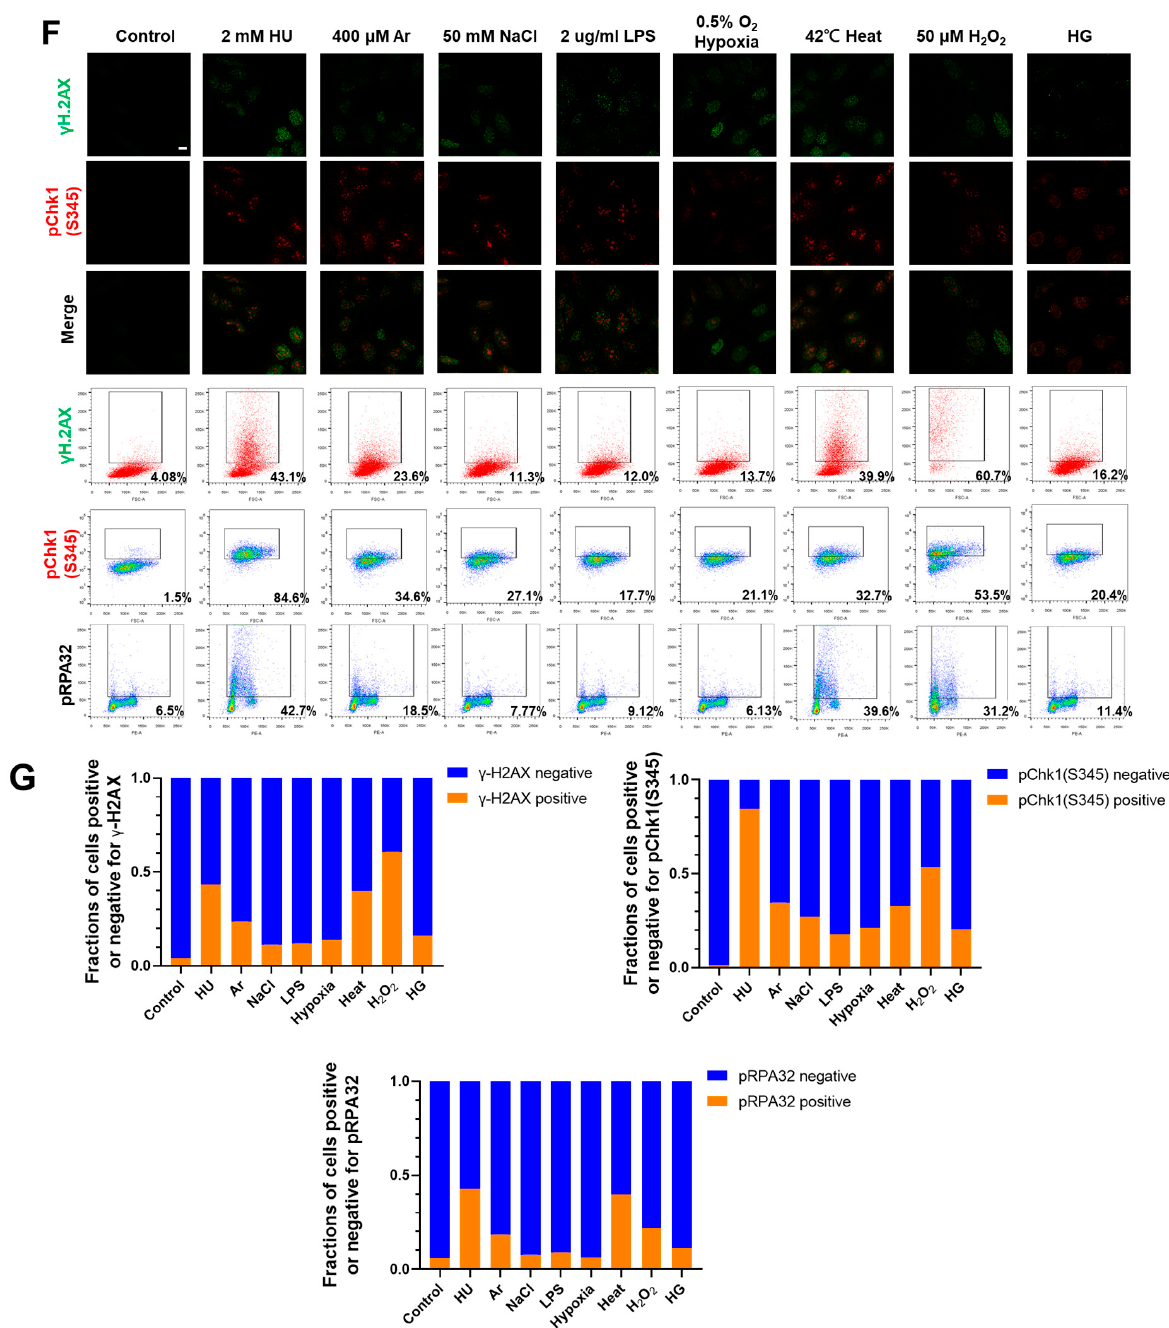
Figure 1. Various cellular stresses differentially affect DNA replication and induce DNA damage and replication checkpoint in a cell-cycle stage-dependent manner. ( A ) U2OS cells were exposed to indicated cellular stresses for 3 h, EdU-labeled for 15 min, and stained with indicated markers. Cells were then visualized and analyzed by confocal microscopy (Zeiss LSM780). Representative images are shown. Scale bar is 10 µ m. Green, DAPI (DNA); white, EdU (DNA synthesis); red, pChk1(S345) (replication checkpoint); green, γ -H2AX(DSB). A long exposed version of pChk1 (S345) is also shown. ( B ) and ( C ) U2OS Fucci cells were exposed to indicated cellular stresses for 3 h and subjected to immunostaining. Cells were then analyzed by confocal microscopy (Zeiss LSM780). Representative images are shown. Scale bar is 10 µm. Blue, Hoechst (DNA); green, geminin (S/G2 marker): red, Cdt1 (G1 marker); white, γ -H2AX; yellow in the merged image, G1/S boundary. ( D ) and ( E ) Left: Fractions of U2OS Fucci cells containing γ -H2AX ( D ) and pChk1(S345) ( E ) foci were quantified for each cell-cycle population. Right: The mean fluorescent intensity of γ -H2AX ( D ) and pChk1(S345) ( E ) was quantified for each cell-cycle population. AU: arbitrary unit. ( F ) U2OS cells were exposed to different stresses for 3 h, and then were subjected to γ -H2AX (green), pChk1(S345) (red), and pRPA32 (S4/8) (phosphorylated single-stranded DNA binding protein representing DNA damage)